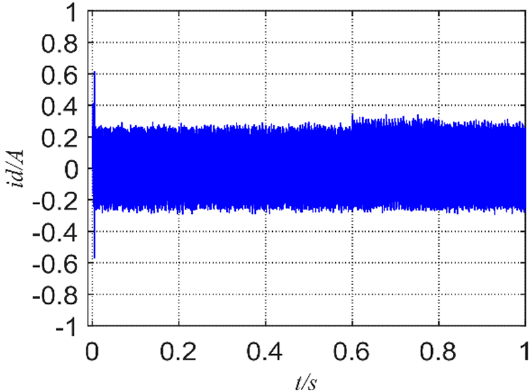
Figure 6. d -axis current of FCS-MFPCC.